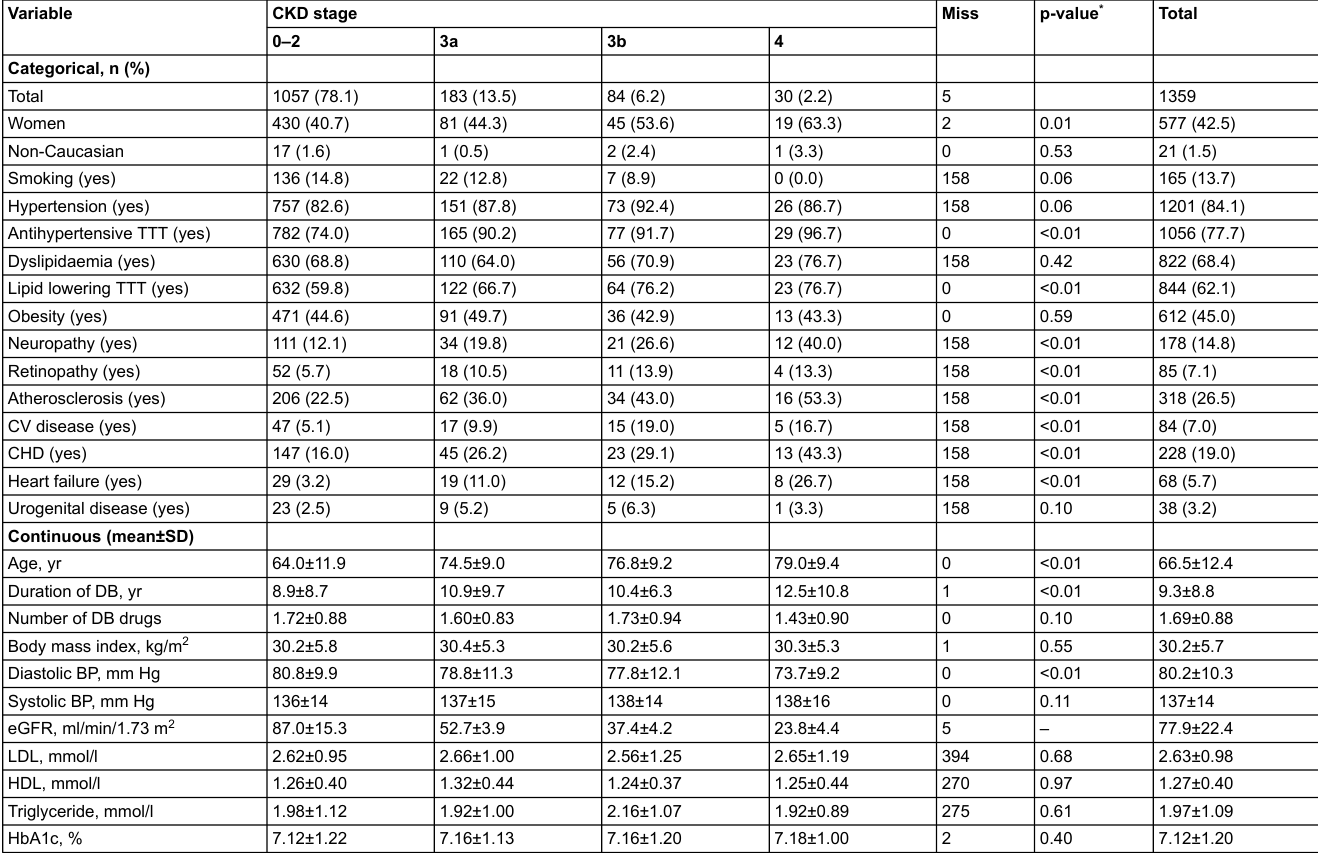
Table 1: Characteristics of participants according to stage of chronic kidney disease (n =